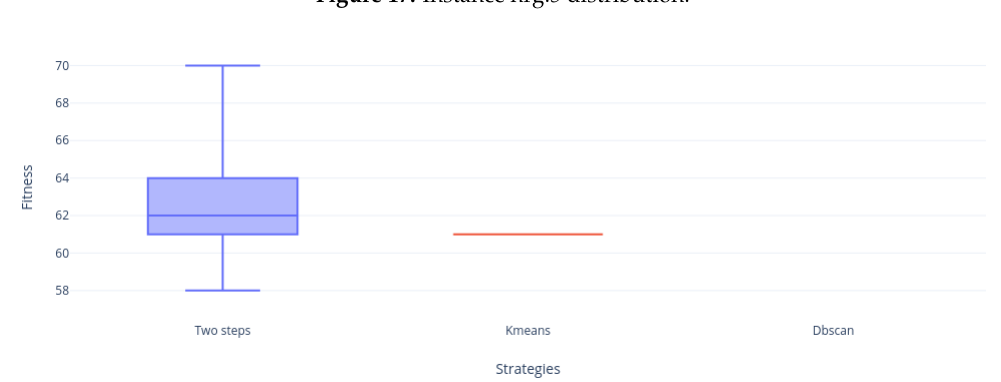
Figure 18. Instance nrh.5